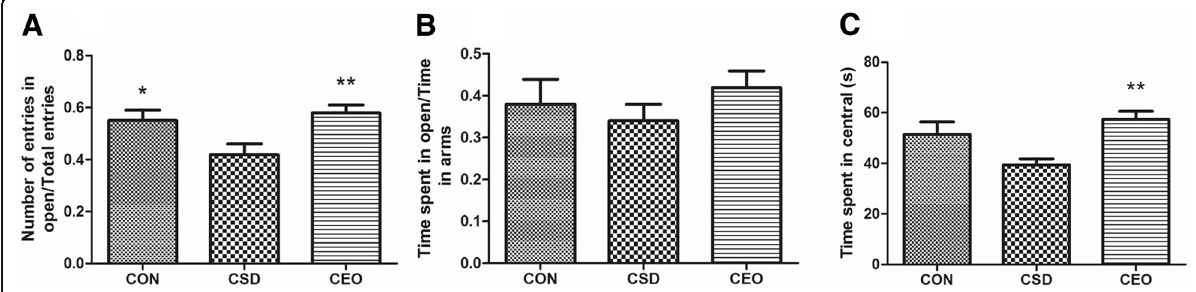
Fig. 5 Assessment of elevated plus maze. All data were represented as the mean ± SEM ( n = 11), * refers to p < 0.05 **refers to p < 0.01 vs. CSD group. The ratio of number of entries in the open /total entries ( a ) in CSD group decreased significantly compared with CON group. CEO increased the ratio. There was no significant difference in the ratio of time spent in open/total arms ( b ), whereas the trend showed same as before. The reduction of central time ( c ) in CSD was not significant, however the treatment CEO increased the measure compared with CSD